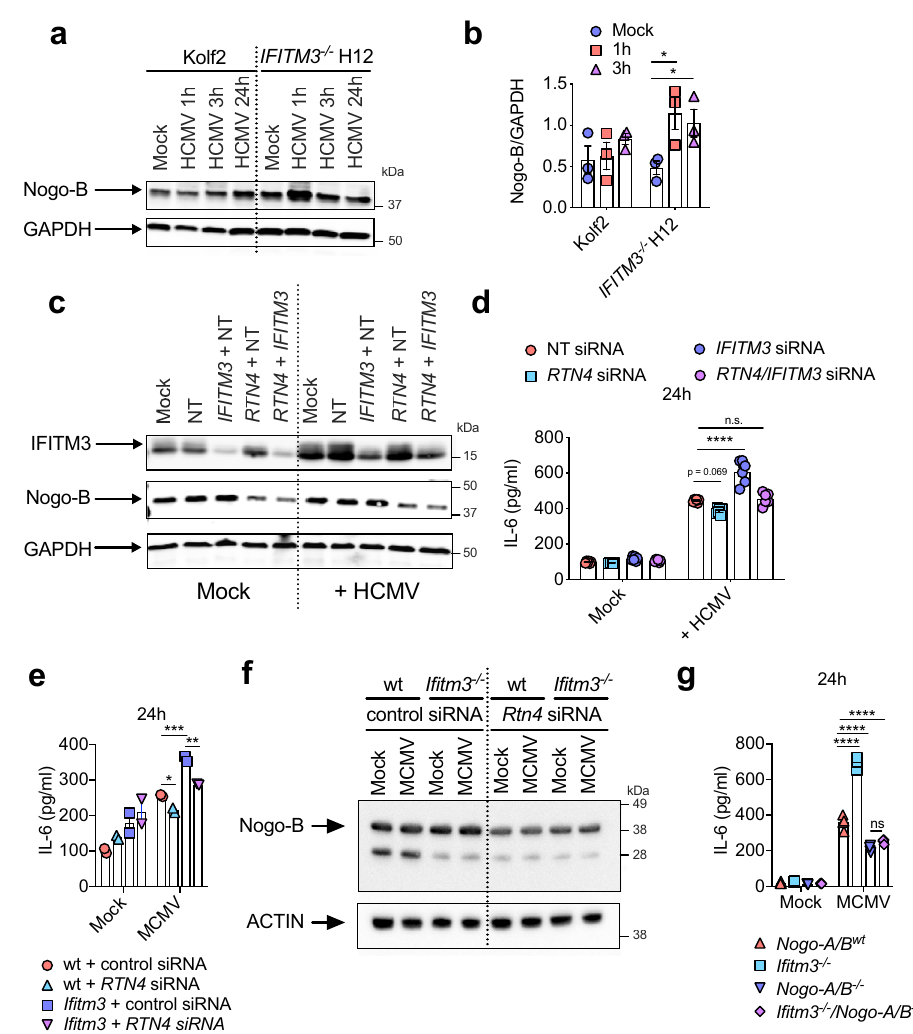
Fig. 4 | Nogo-B/IFITM3 interaction regulates CMV-induced IL-6. a Nogo-B and GAPDH was detected by Western blot, after stimulation of Kolf2 and IFITM3 − / − H12 iPS-DCsfor 1, 3 or 24h withHCMV(MOI5), ormock treatment, and preparationof whole-cell extracts. Data represent three experiments. b Relative expression of Nogo-BtoGAPDHfrom a wasassessedusingImageJsoftware.Mean±SEMofthree biological replicates are shown. c THP-1s were treated for 72h with RTN4/Nogo , Non-targeting (NT) and/or IFITM3 siRNAs and assayed for anti-IFITM3 and anti- Nogo-B by Western blot 72h after siRNA addition and preparation of whole-cell extracts. Data represent two separate experiments. d THP-1s ( n =6 separate cell cultures in different wells) treated for 72h with RTN4/Nogo , Non-targeting (NT) and/or IFITM3 siRNAs were stimulated with HCMV (MOI 5) for 24h, with IL-6 in supernatant measured. e BM-DCs ( n =2, n =4 separate cell cultures in different